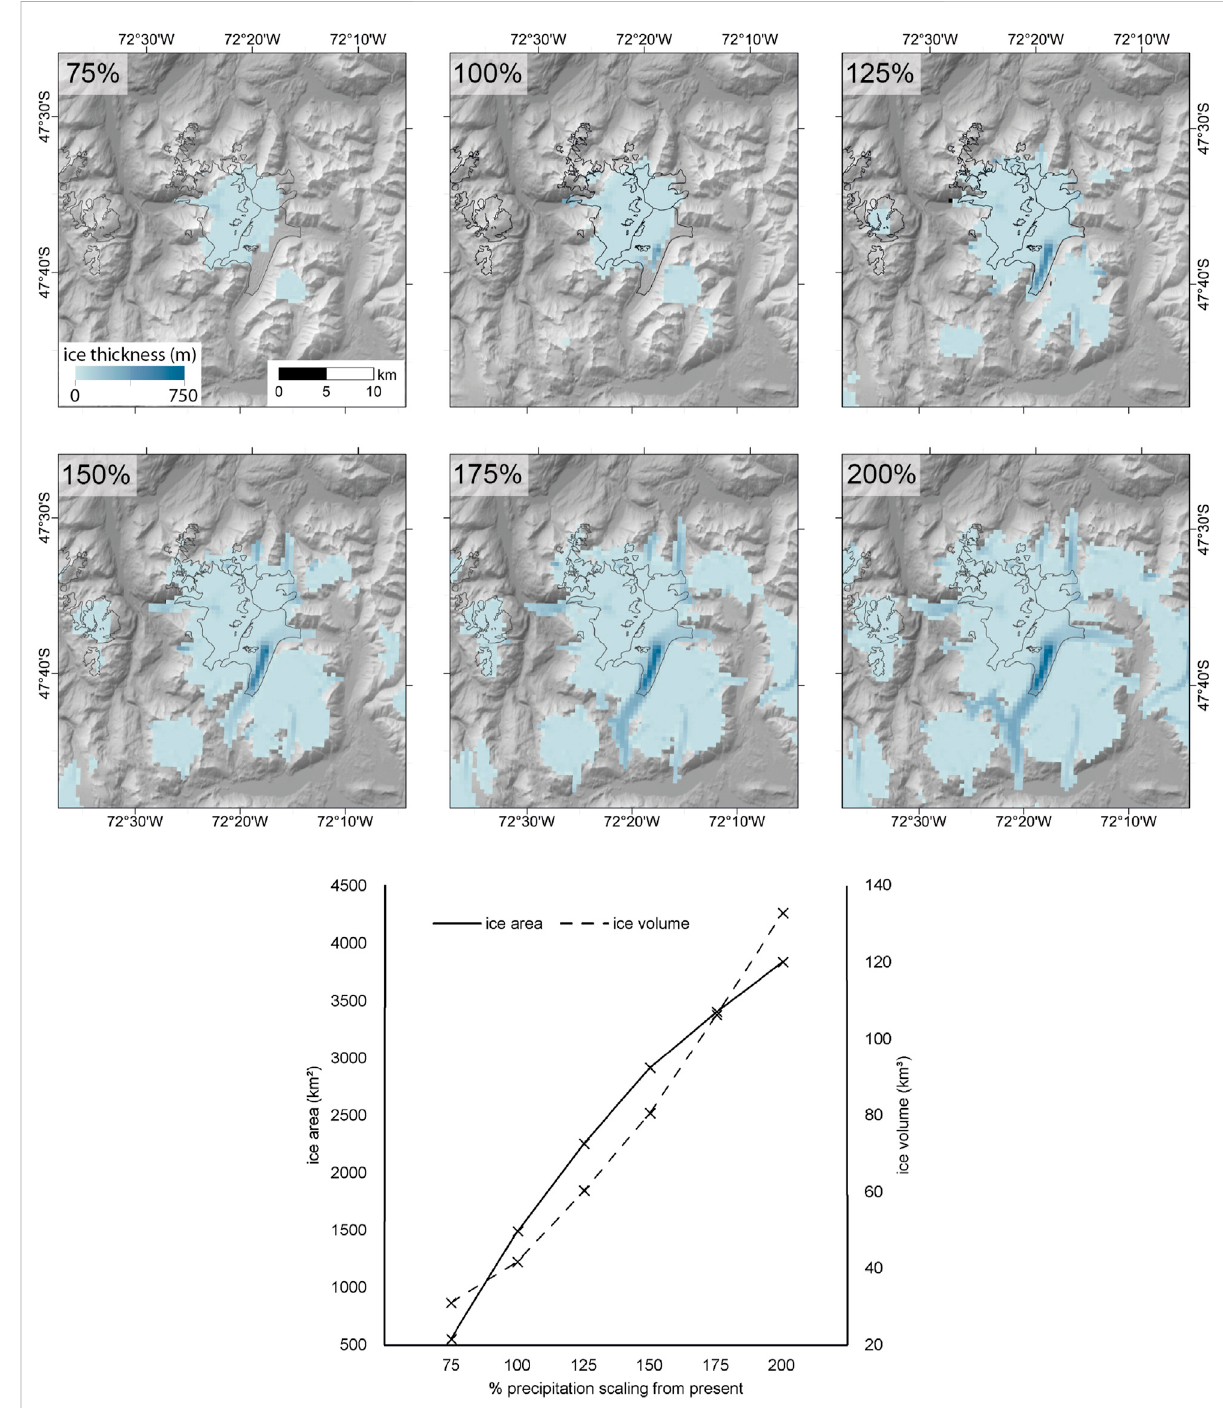
FIGURE 5 ExperimentF.ModelsimulationsoftheMSLicecapunderincreasinglyscaledprecipitationforcingfrompresent-day.Surfaceairtemperatureis set constant to present-day. Present-day ice extent shown as black outline. Graph shows modelled ice area and volume at equilibrium through fi ve simulations under increasingly scaled precipitation